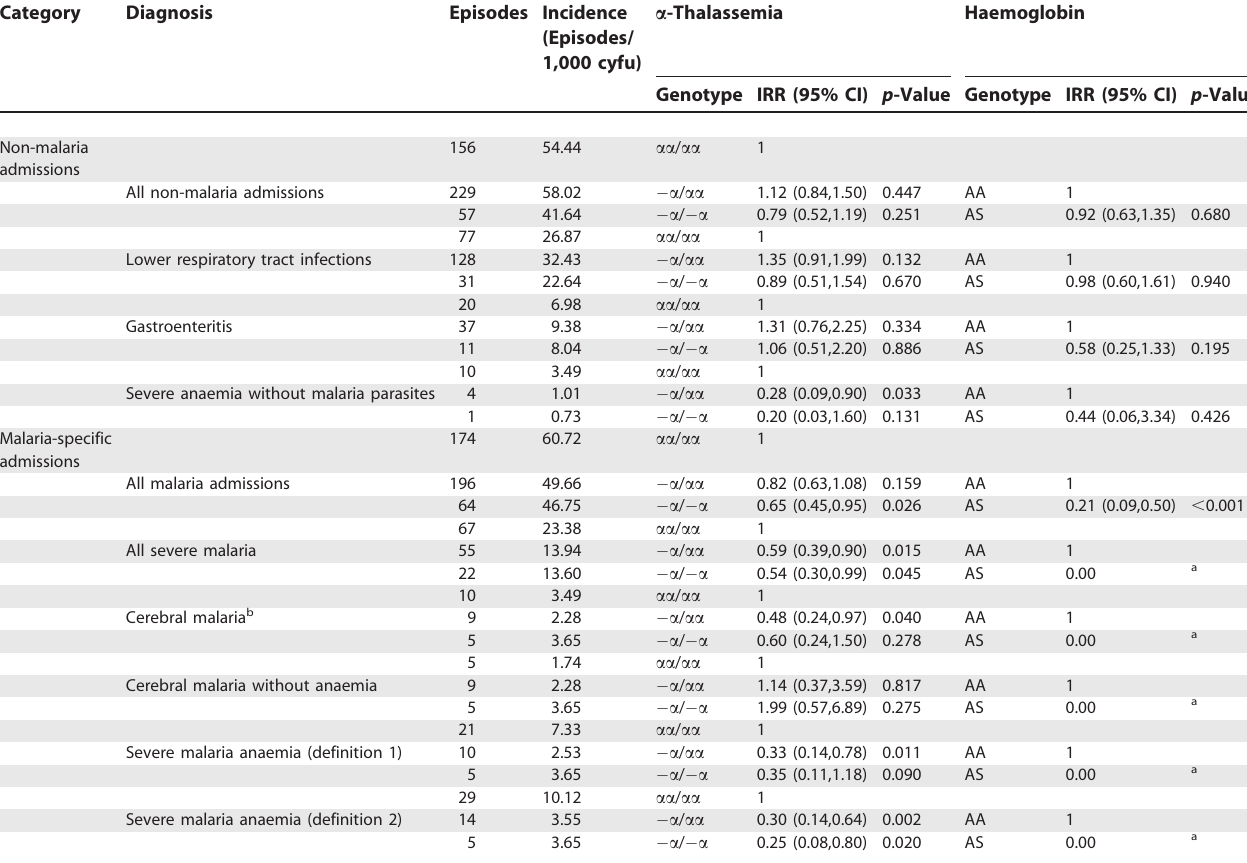
Table 2. The Incidence of Severe Clinical Events by a þ -Thalassaemia Genotype Category